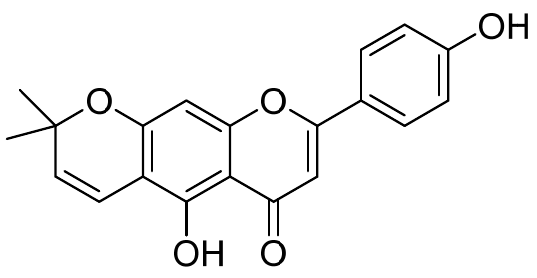
Figure 7. Chemical structure of carpachromene extracted from the ethyl acetate fraction of fresh leaves of Ficus benghalensis .